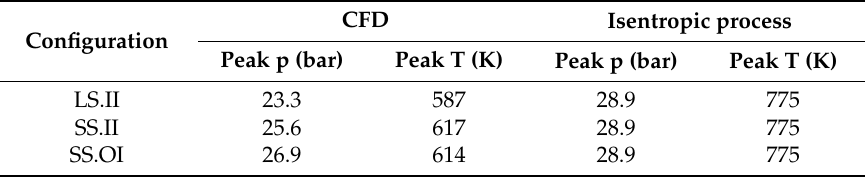
Table 2. Optimization of intake port and sealing